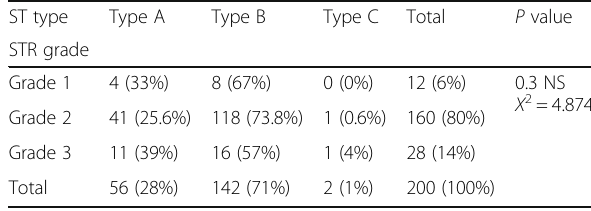
Table 3 Supratubal recess (STR) grading in relation to